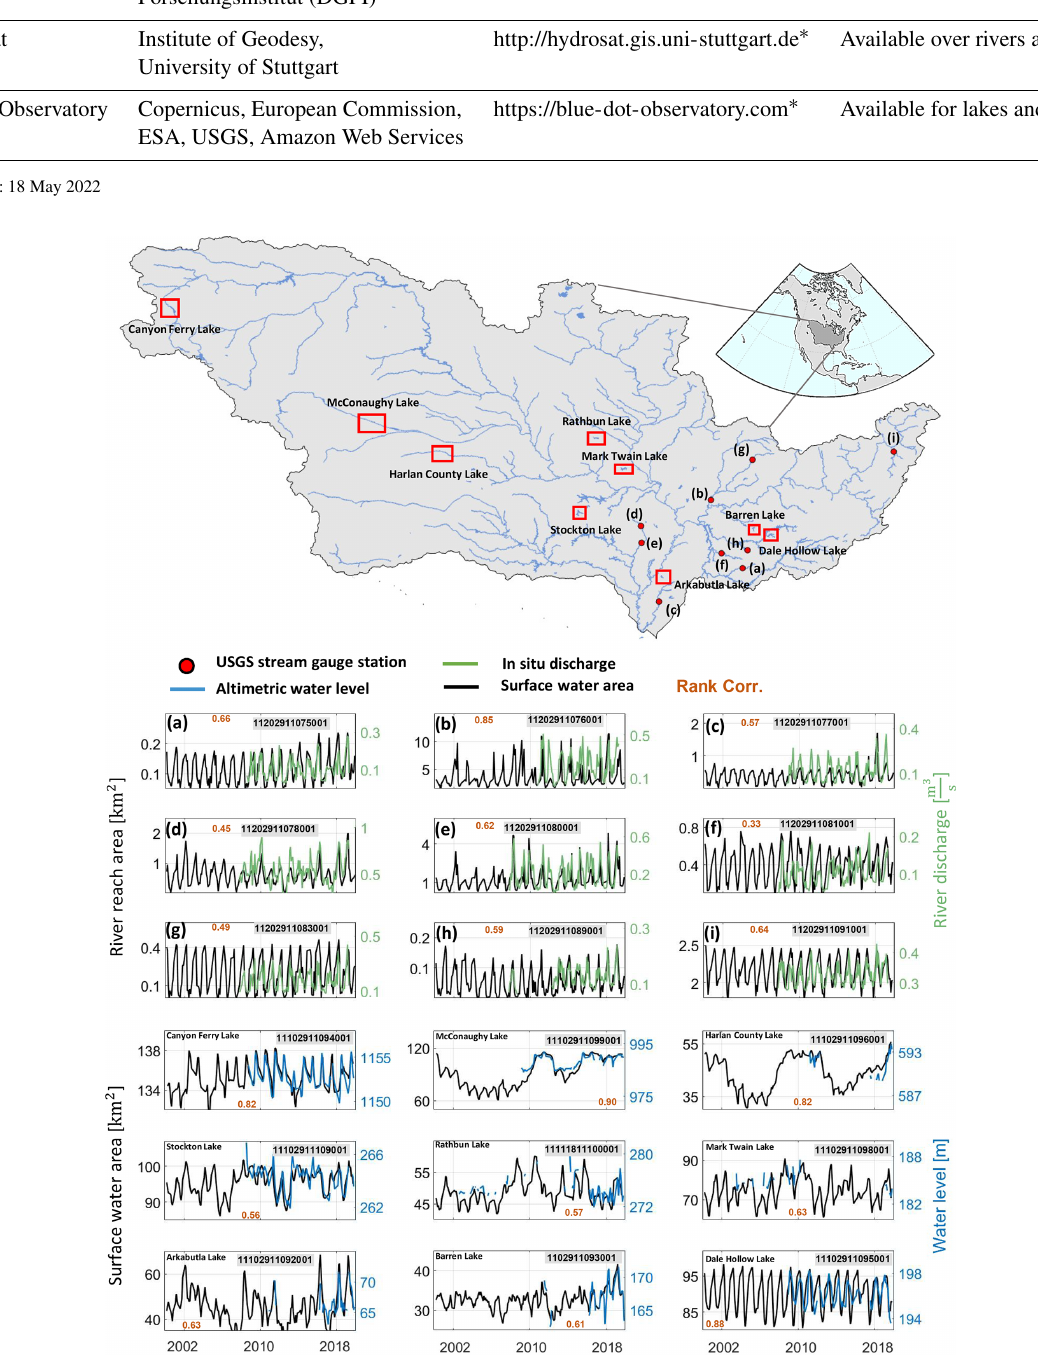
Earth Syst. Sci. Data, 14, 2463–2486, 2022